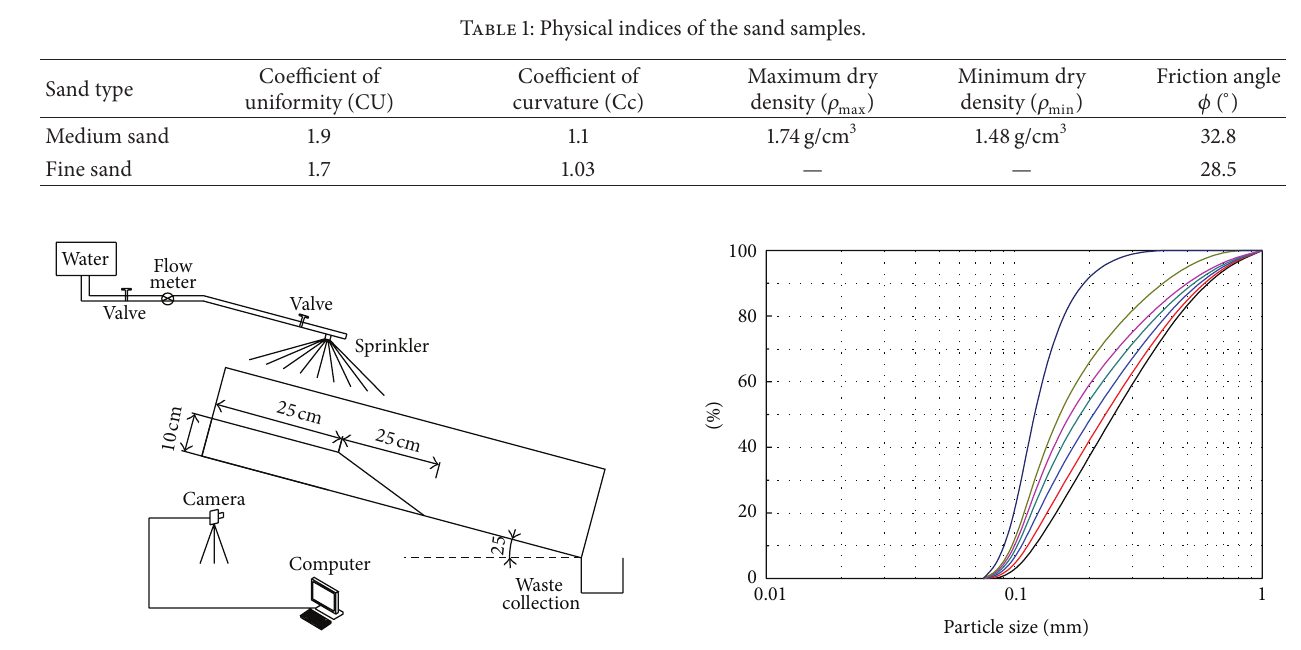
Figure 1: Debris flow test system.